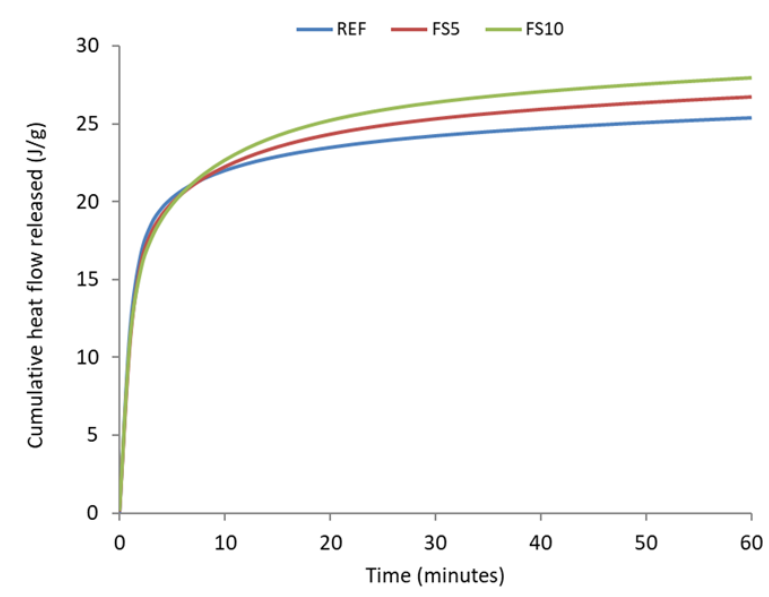
Figure 15. Cumulative heat release of REF, FS5, and FS10 during the first 60 min.